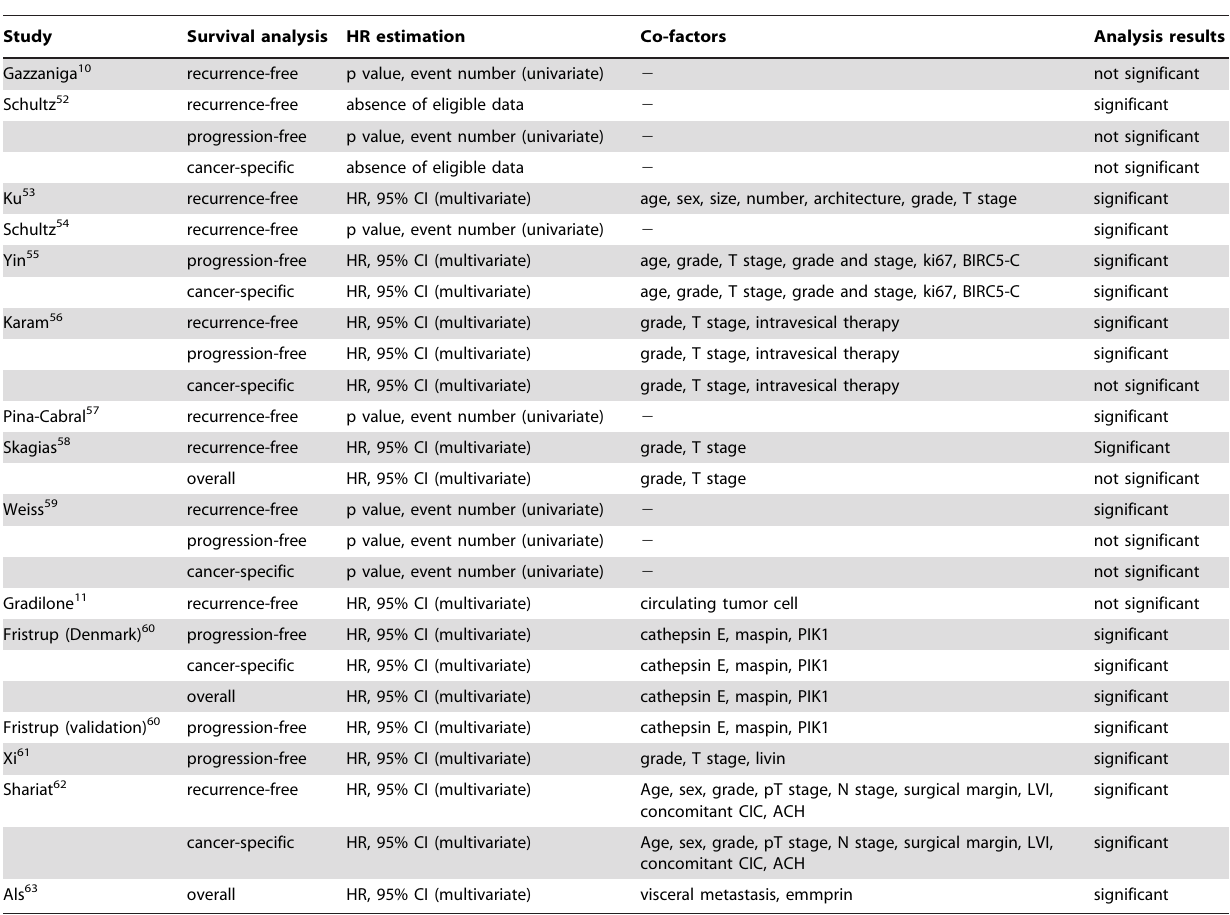
Table 2. Estimation of the hazard